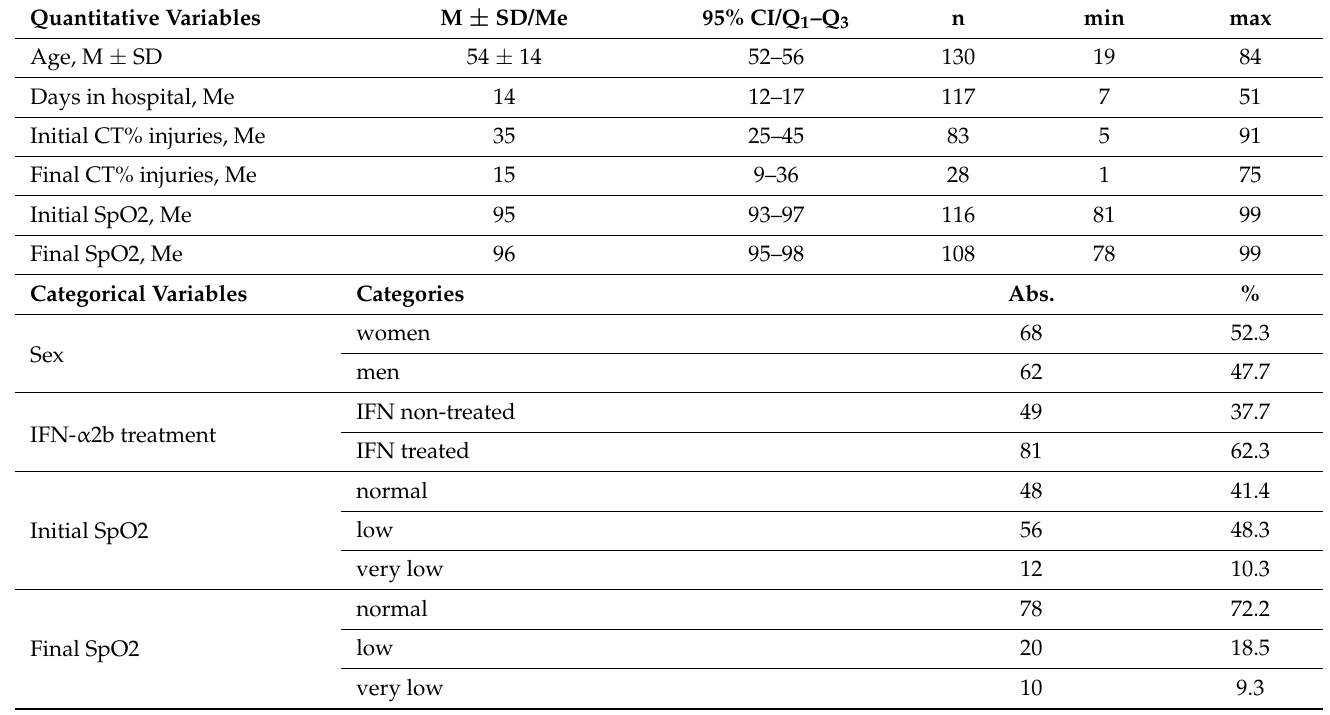
Figure 1. Patient characteristics. Distribution of sex ( A ) and age ( B ) within the non-treated (dark